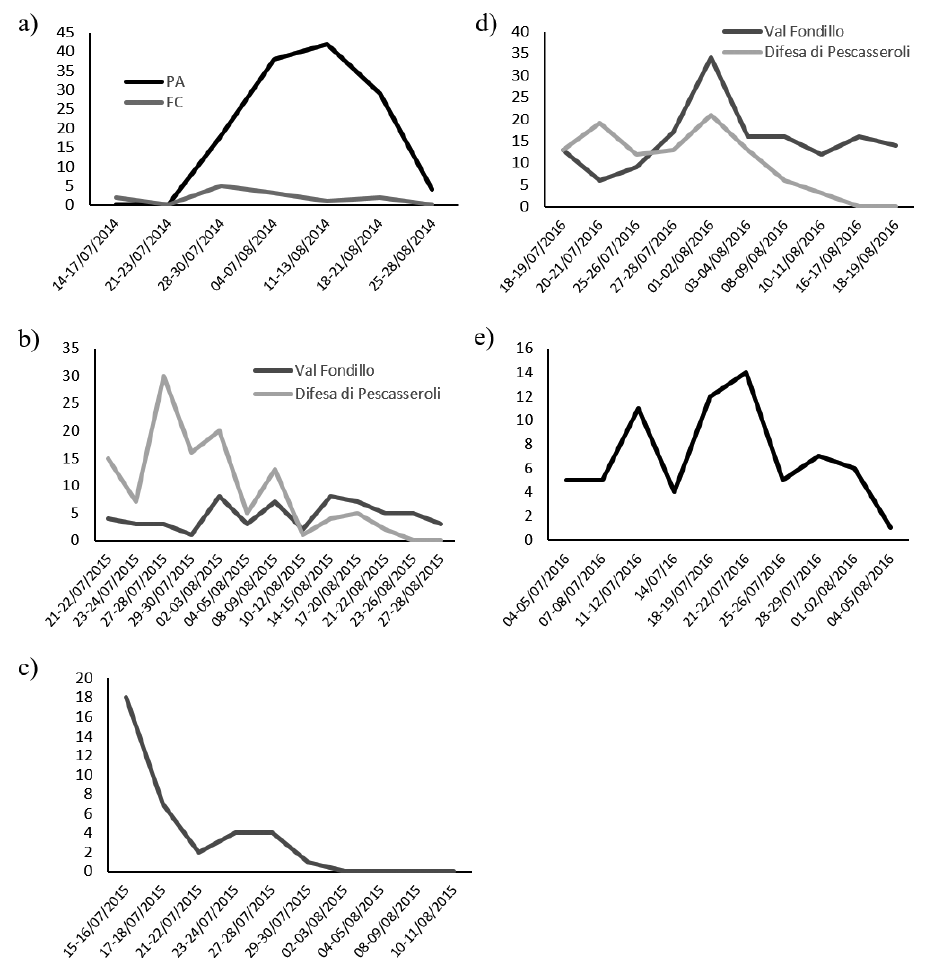
Figure 12. Phenology of R. alpina in the study areas. The dates of survey and the numbers of observed individuals are plotted. A) year 2014, study areas PA and FC (data of different sub-areas have been summed) B) year 2015, study area PA (the data of different sub-areas have been maintained separate) C) year 2015, study area FC (data of different sub-areas have been summed) D) year 2016, study area PA (the data of different sub-areas have been maintained separate) E) year 2015, study area FC (data of different sub-areas have been